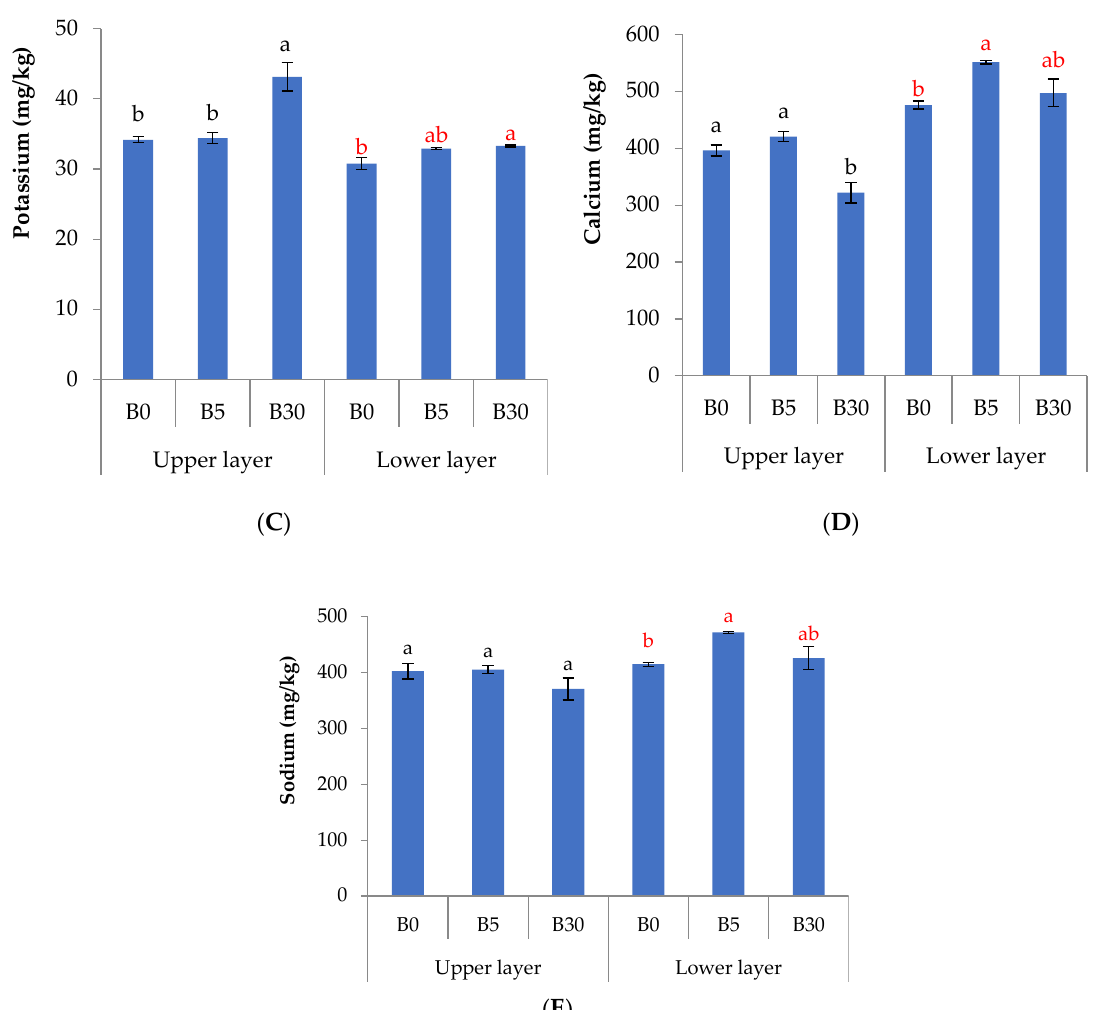
Figure 1. Soil chemical properties in upper and lower layers with 0.3% (B5), 1.8% (B30) or without (B0) biochar amendment to the upper layer; ammonium nitrogen (N-NH 4 ) ( A ), nitrate nitrogen (N-NO 3 ) ( B ), soluble K ( C ), soluble Ca ( D ), and soluble Na ( E ). Bars present the means and standard errors (n = 3). Different letters indicate the significant differences ( p < 0.05) among treatments of each upper layer and lower layer by Tukey’s HSD test.